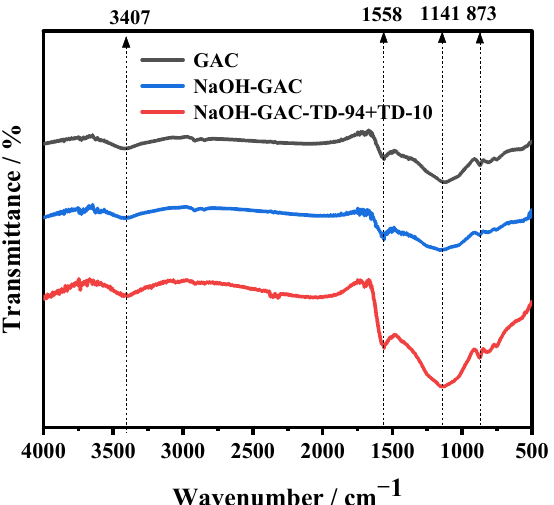
Figure 2. FTIR patterns of unmodified carrier, modified carrier, and modified carrier with immobi- lized cells. (TD-94 + TD-10 represents Alcaligenes sp. TD-94 and Paracoccus sp. TD-10.).